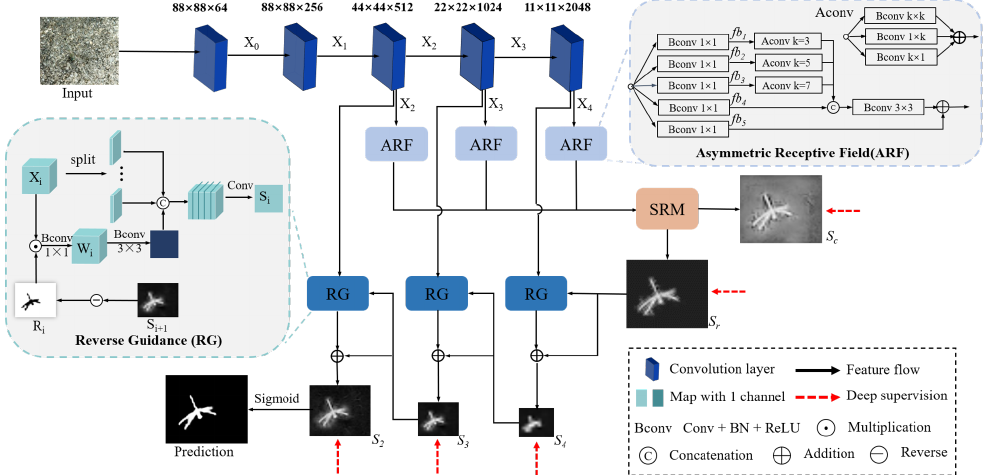
Figure 5. Overview of the proposed network, which consists of three main modules: asymmetric receptive field (ARF) module, self-refinement module (SRM) and reverse guidance (RG) module (Best viewed in